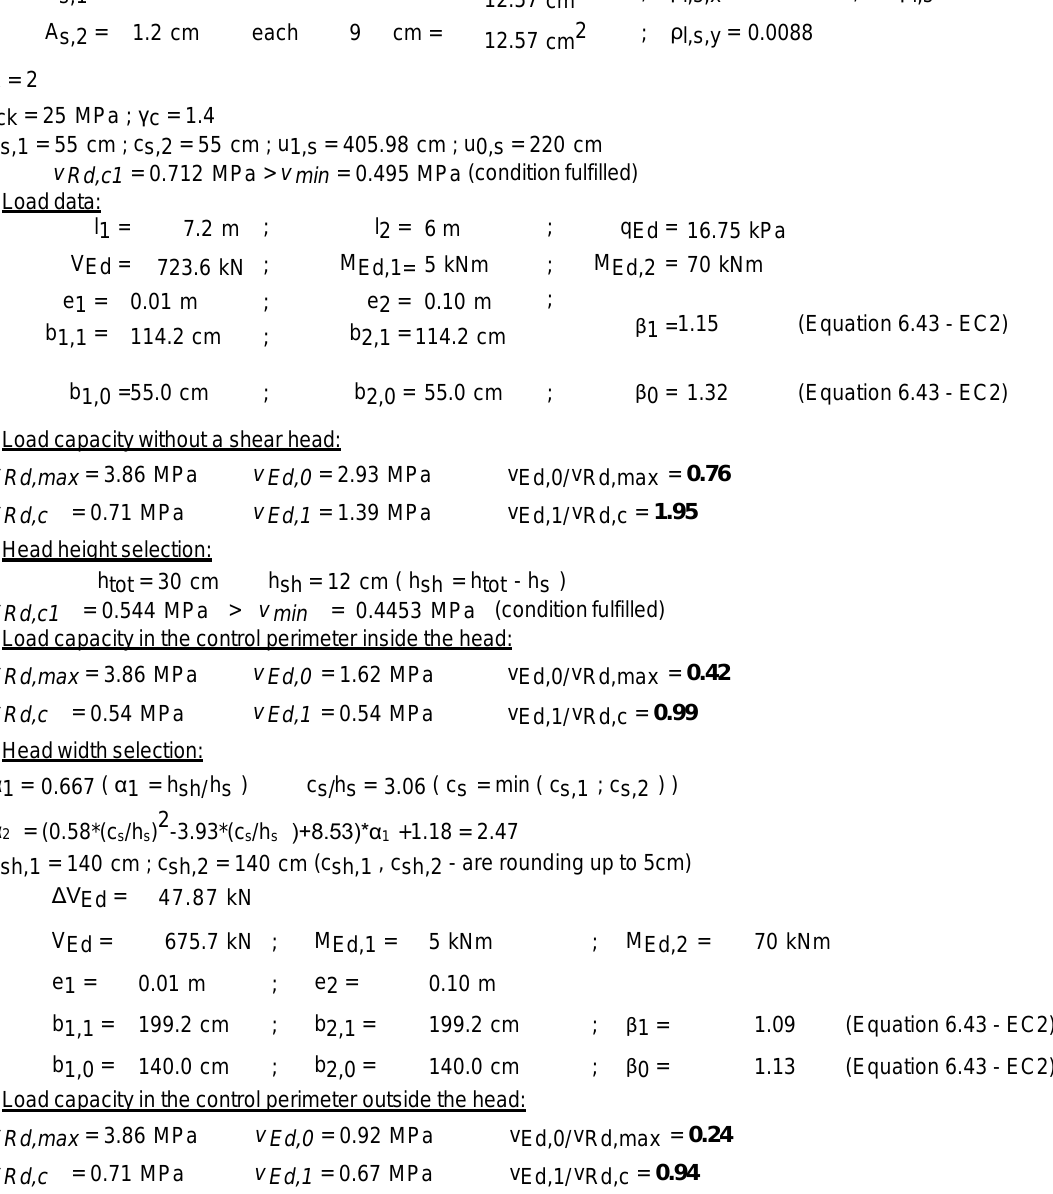
Figure A3. Verification example no. 3—EC2.